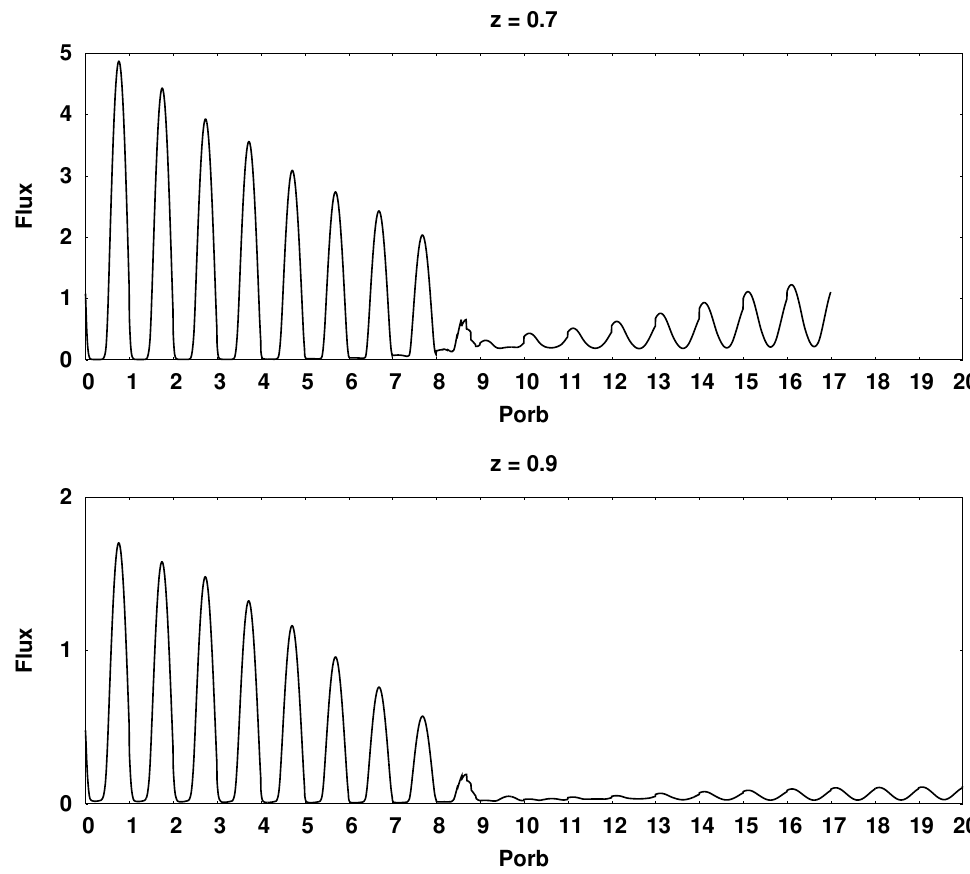
Figure 16. Synthetic bolometric light curves of the CD Ind polar for various values of the dipole displacement at the moment of switching the flow from the south magnetic pole to the north. The flux values are in units 10 33 erg/s. At the top of each panel, the value of the displacement of the dipole center is